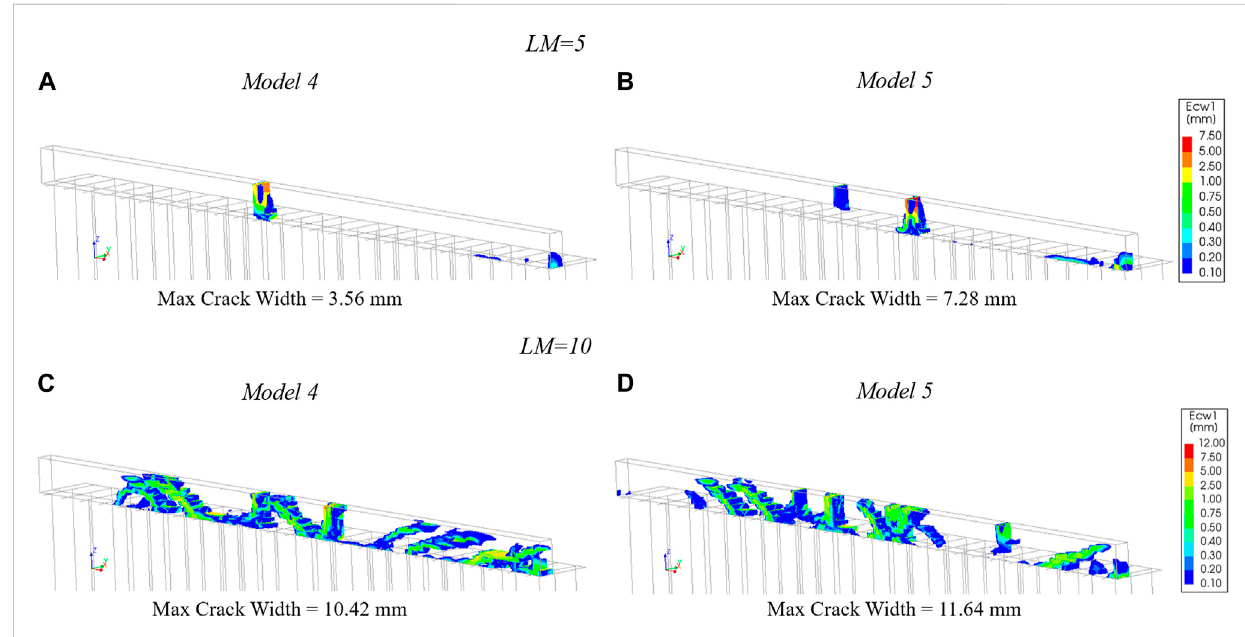
FIGURE 13 Maximum principal crack widths developed during the passage of the fi re-truck: with LM = 5 for (A) Model 4 ; (B) Model 5 and with LM = 10 for (C) Model 4 ; (D) Model 5 .